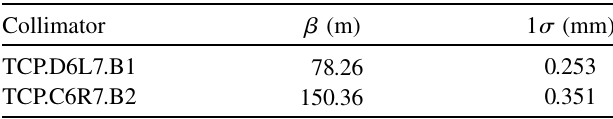
TABLE III. The (cid:2) functions and 1 (cid:5) nominal beam sizes at the collimators used in the